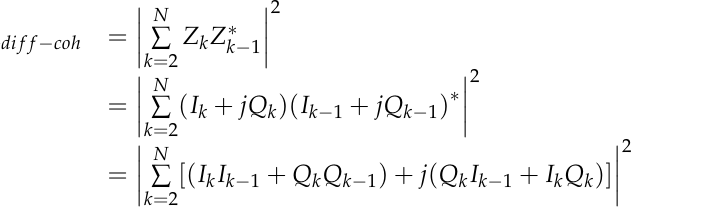
Figure 3. The schematic diagram of differential coherence integration.